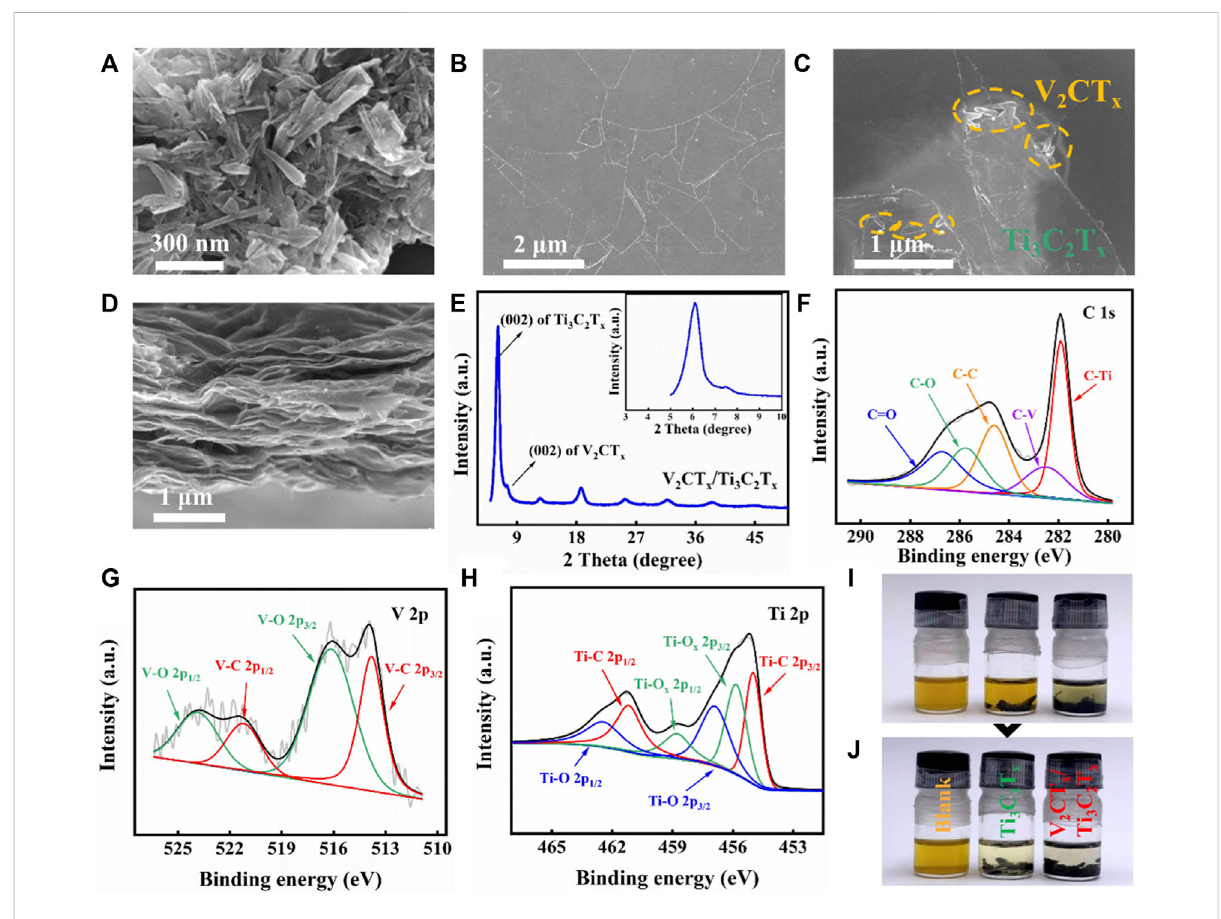
FIGURE 1 SEM images of (A) V 2 CT x nanorods, (B) Ti 3 C 2 T x nanosheets, and (C) V 2 CT x /Ti 3 C 2 T x composite interlayer. (D) Cross-sectional SEM image and (E)